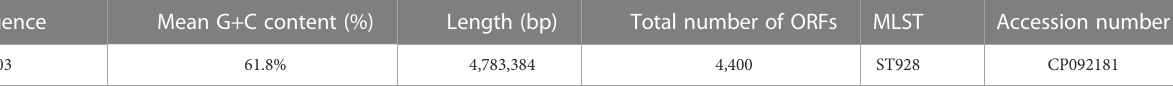
TABLE 2 Whole genome information of A. caviae